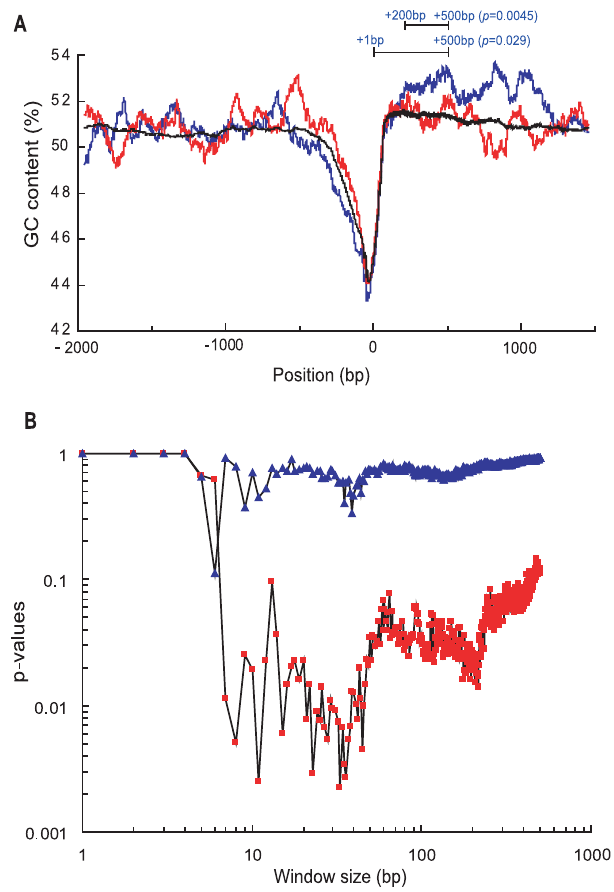
Figure 4. Comparison of the GC Content in Upstream and Coding Regions of Activated and Repressed Genes (A) The GC content of the DNA regions from (cid:1) 2,000 to þ 1,500 nt, relative to the translation start site, of 84 activated (red) and 95 repressed (blue) genes was calculated with a 100-nt moving window (black: the average GC content of the genome). The significance of the GC content differences in a given region was determined by comparing the average GC content of the repressed genes with the GC content of 10,000 randomly sampled sets of similar fragments in the genome. (B) DNA windows, from 1 nt to 500 nt, were compared to assess their GC content in (cid:1) 500-nt upstream regions. The p -values were determined by comparing the averages of the maximal GC content values of the activated (red square), or repressed (blue triangle), genes with the corresponding values of 10,000 randomly sampled sets from the whole genome. DOI: